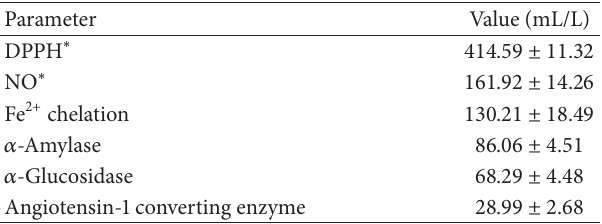
Table 3: EC of DPPH and NO radical scavenging abilities, Fe 2+ 50 chelating ability, and inhibition of 𝛼 -amylase, 𝛼 -glucosidase and angiotensin-1 converting enzyme activities by black pepper essential oil